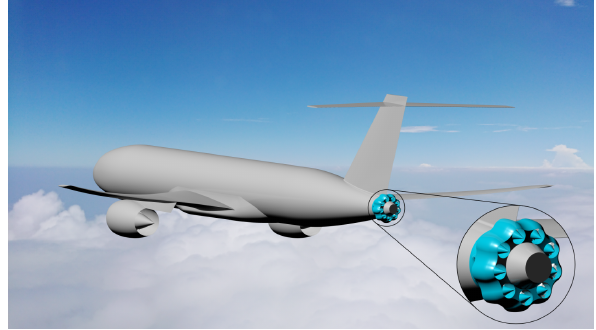
Figure 1. Distributed aft-fuselage BLI aircraft